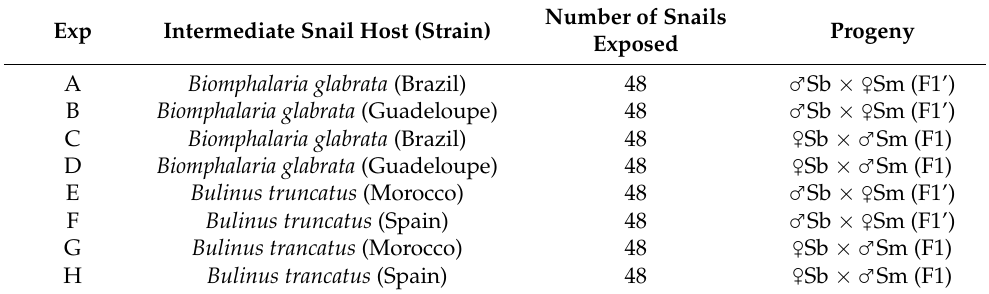
Table 2. Snail infection with F1/F1’ miracidia for compatibility testing. Sb: S. bovis , Sm: S. mansoni